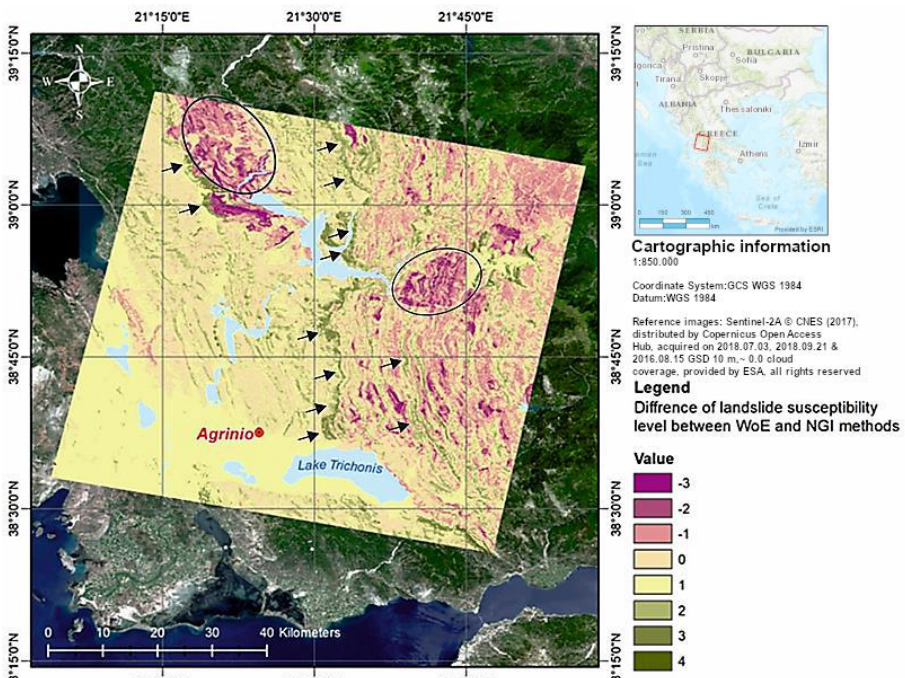
Figure 14. Difference between (WoE) and NGI methods. The circles point out areas mistakenly rated with higher landslide susceptibility index by the NGI method. The arrows point the green colored strips referring to the major thrust zones of the Pindos geotectonic zone indicated by the NGI method as zones of low landslide susceptibility.